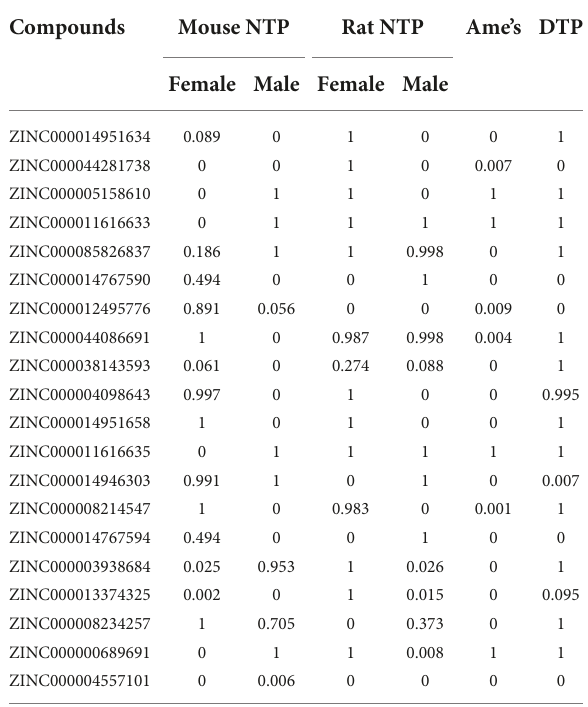
TABLE 4 Toxicities of